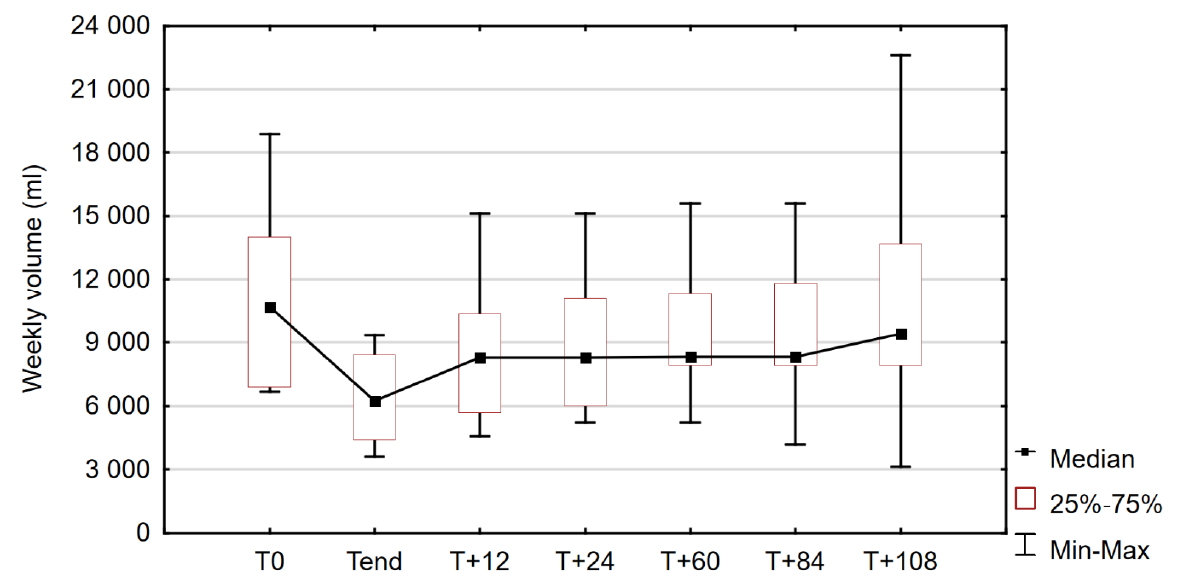
Figure 4. Comparison of weekly volumes of parenteral nutrition (PN) before and after treatment with teduglutide (TED) and 12, 24, 60, 84, and 108 months later; Friedman test: χ 2 = 34.860, p < 0.001. At 12 months (1 year) after discontinuation of TED (T +12 ), weekly volumes of paren- teral nutrition were increased by 13.9–101.6% (median 44.4%) in 69.3% of patients ( n = 9) compared with post-treatment values (T end ), corresponding to an increase of 1000–6720 mL (median: 1670) per 7 days. In three patients (23%), the PN volume remained un- changed and in one case a decrease of 1500 mL was observed. In one patient, the weekly volume at T +12 exceeded baseline (T 0 ) by 1820 mL, but the mean values at T +12 were still statistically significantly lower in the study group than before administration of TED ( p =